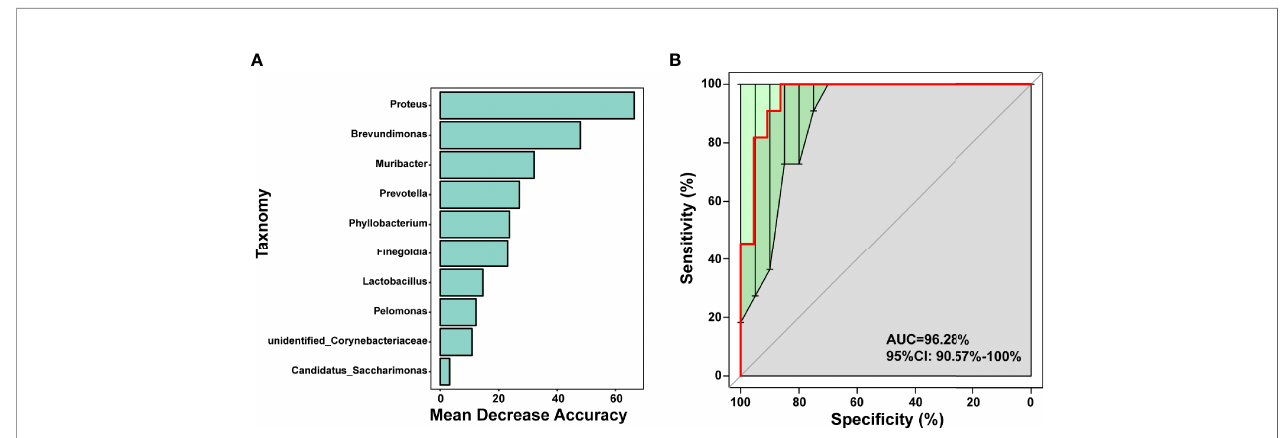
FIGURE 4 | Prediction model of the airway microbiota for AR status based on the genus-level relative abundances using random forests. (A) variable importance ranking chart, MeanDecreaseAccuracy measures the degree to which the prediction accuracy of a random forest decreases by changing the value of a variable to a random number. A higher value indicates that the variable is more important. (B) ROC curve of the AR model using 10 discriminatory genera.